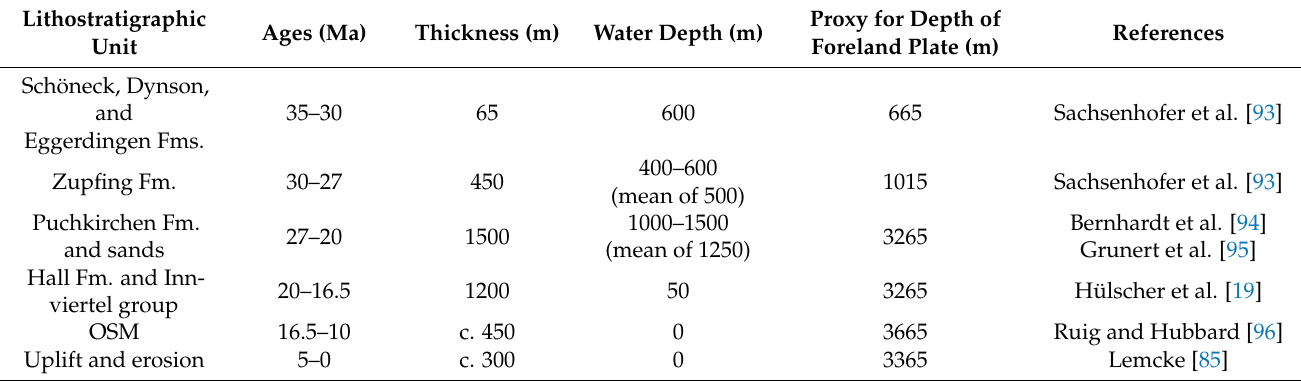
Table 4. Source information that was used to calculate the subsidence pattern of the foreland plate underlying the Austrian part of the Molasse basin near Salzburg (see site labelled as A in Figure 2 for